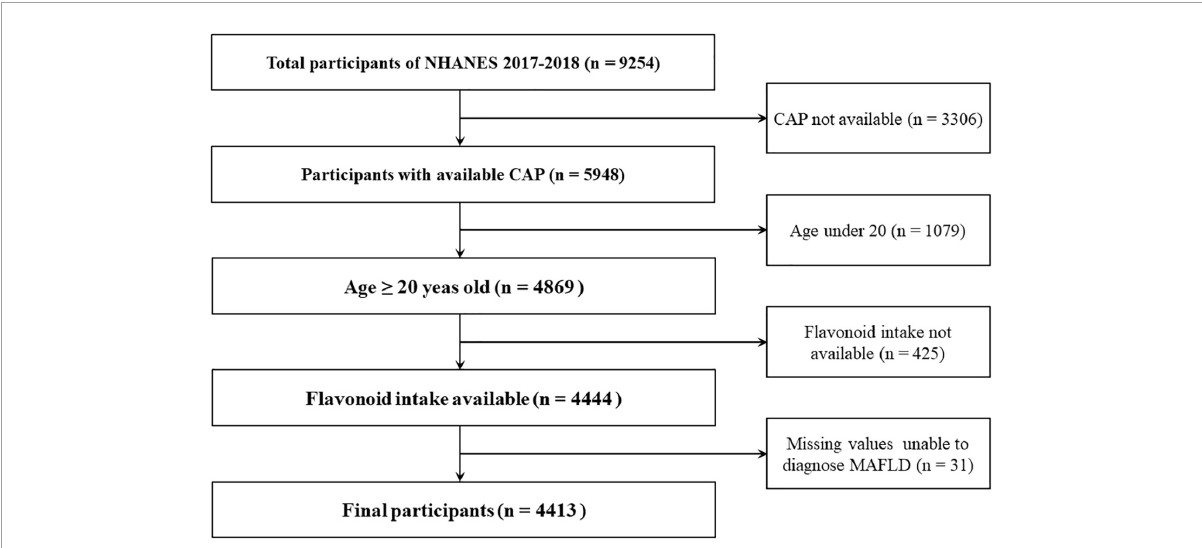
FIGURE1 Flow chart of participants selection. NHANES, National Health and Nutrition Examination Survey; CAP, controlled attenuation parameter.